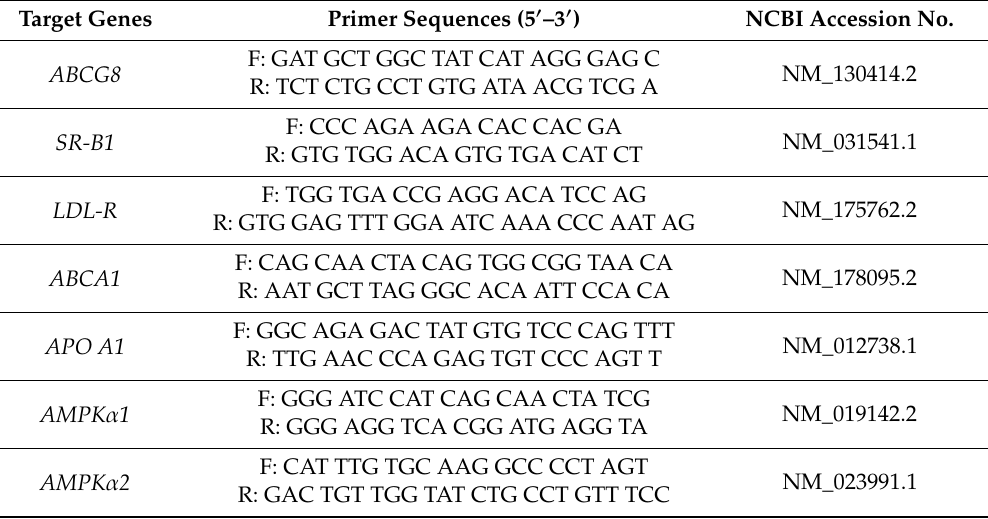
Target Genes Primer Sequences (5 (cid:48) –3 (cid:48)